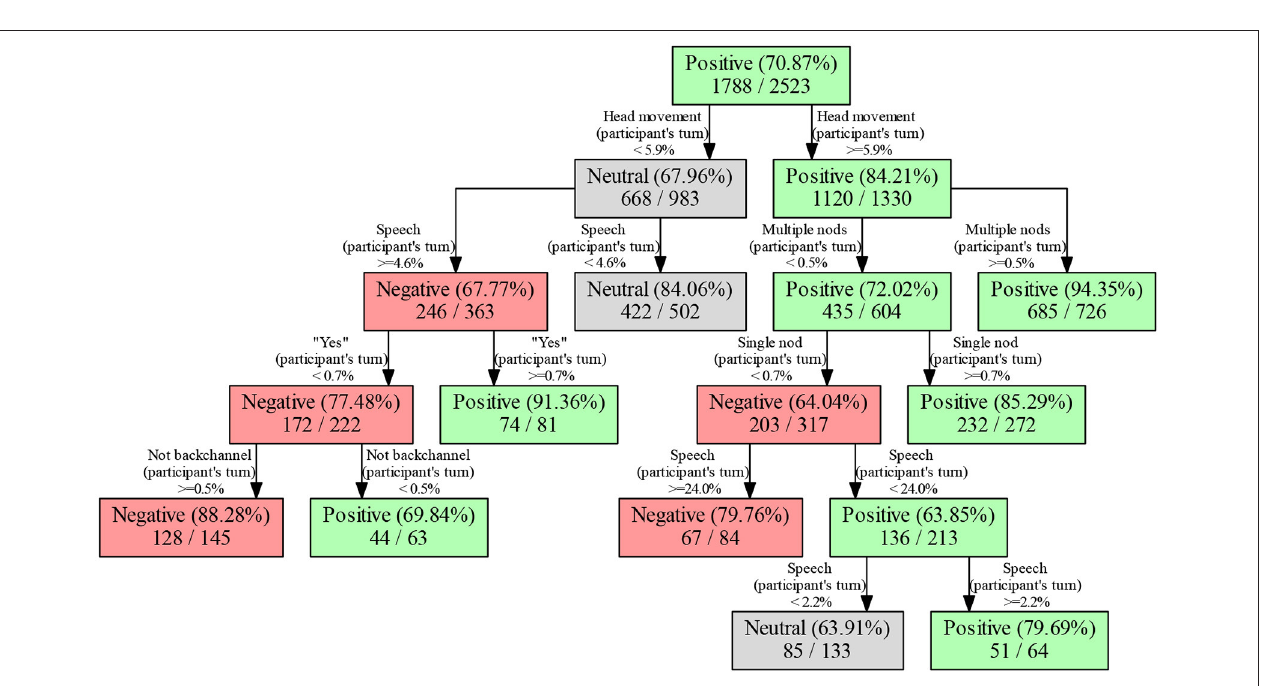
FIGURE 6 | The RPART tree for fractional, split data, with fold 6 used as test